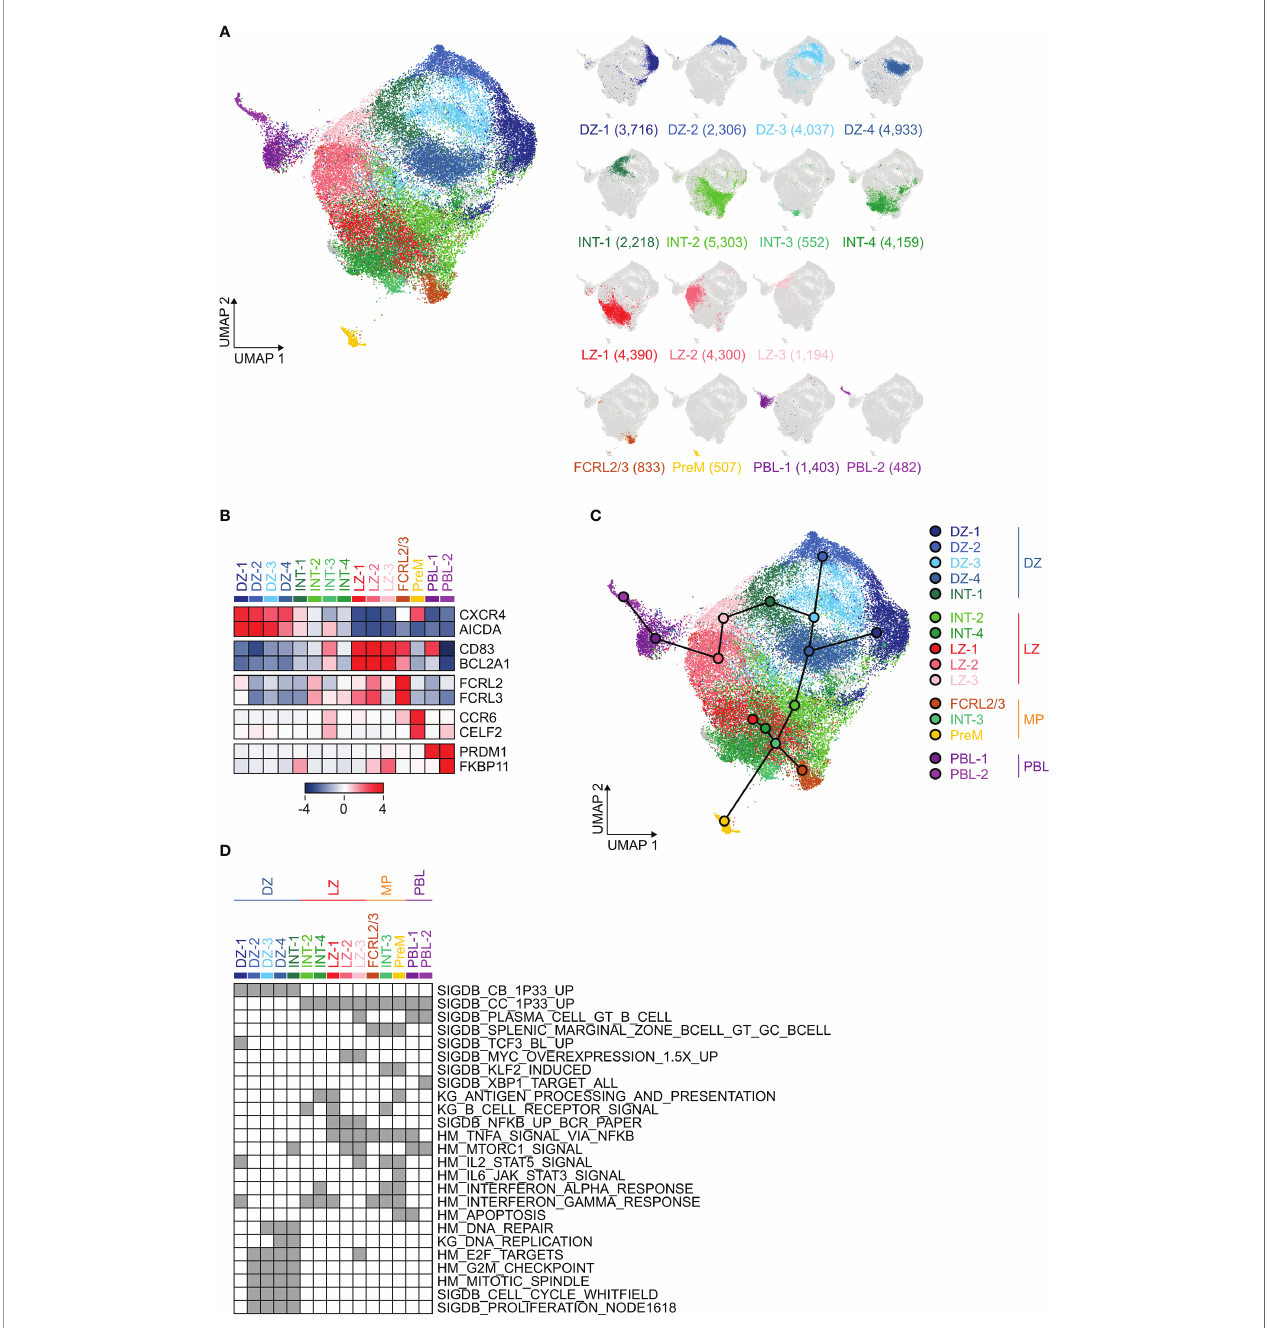
FIGURE 1 | Identi fi cation and characterization of germinal center (GC) B cell subpopulations by single-cell (sc)-transcriptomic analysis. (A) UMAP projection of sc- RNAseq pro fi les of 40,772 cells including GC (CD3 − , IgD − , CD38 + ), dark zone (DZ, CD3 − , IgD − , CD38 + , CD83 lo , CXCR4 hi ) and light zone (LZ, CD3 − , IgD − , CD38 + , CD83 hi , CXCR4 lo ) cells isolated from three donors. Clusters in the UMAP plot were identi fi ed by PhenoGraph and color-coded according to different cell states: DZ, Intermediate (INT), LZ, and committed to post-GC differentiation (FCRL2/3; memory precursors, PreM; plasma blasts, PBL). The right panel displays the UMAP projection labeled to display the cells belonging to each cluster. The number of cells in each cluster is provided in parenthesis. (B) Heat map displaying the relative expression, as z-scored fold change (log2), of selected hallmark genes in the GC B cell clusters identi fi ed in (A) . (C) Pseudo-time analysis inferred trajectories that were projected onto the UMAP with cluster nodes placed in the centroid of each cluster. (D) Pathway enrichment analysis for the gene signatures associated with the clusters identi fi ed in (A) . Selected pathways from KEGG (KG), Hallmark (HM) and Staudt Lab Signature Database (SigDB) that were signi fi cantly enriched (hypergeometric test with Benjamini-Hochberg correction, q < 0.05) are shown in gray. Clusters are organized in four groups (DZ, LZ, memory precursors MP, PBL) based on their similarities, as identi fi ed in (C)